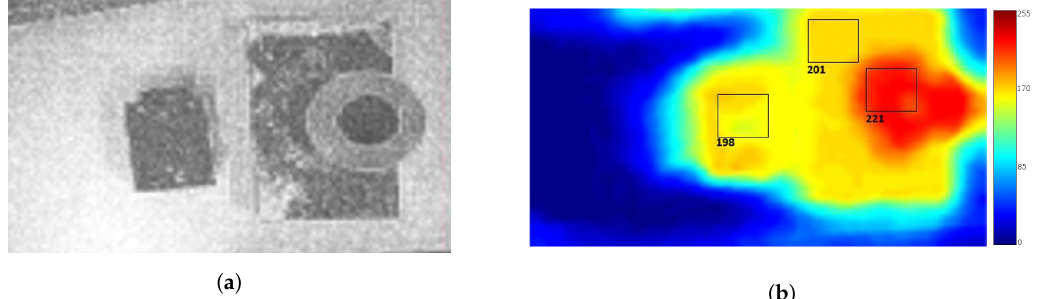
Figure 7. Height estimation using the kinematic stereo method with the addition of a Laplacian filtered image. ( a ) Sum of the original and Laplacian filtered images. ( b ) The height disparity map using the optical flow algorithm with addition of laplacian filtered image to reduce error.